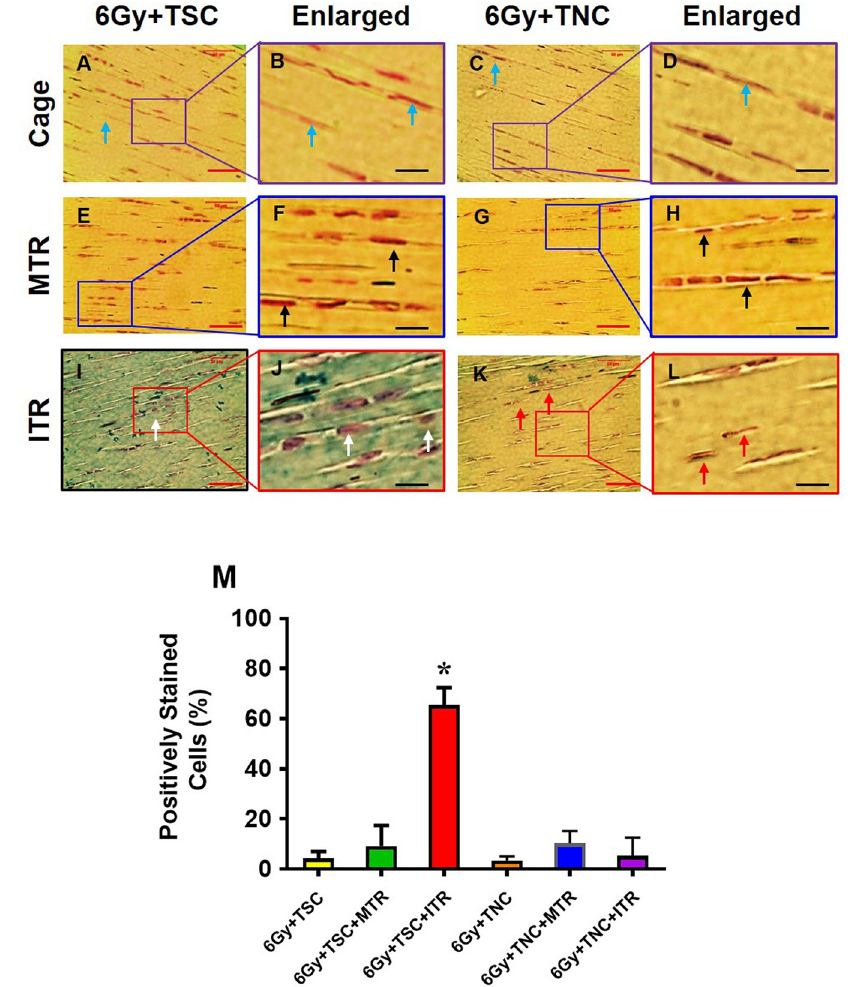
Fig 5. ITR induces chondrogenic differentiation of TSCs in irradiated tendons. Histochemical staining by Alcian blue and nuclear fast red shows that the cells in cage control tendons injected either with TSCs ( A, B ) or with TNCs ( C, D ) are still in elongated shape (blue arrows in A, C ), and very few cells in cage control groups are positive for Alcian blue staining ( A-D ). Furthermore, both TSCs and TNCs in MTR tendons are still elongated shape (black arrows in F, H ) and a few TSCs are positively stained by Alcian blue after MTR ( E, F ). However, some cells in ITR tendons are round shaped (white arrows in I, J ), and many TSCs are positively stained by Alcian blue ( I, J ) after ITR. The TNCs are still in elongated shape (red arrows in K, L ) and very little positive staining by Alcian blue ( K, L ). Semi- quantification of the chondrocyte staining shows that 66% of TSCs are positively stained with Alcian blue, and only 5% TNCs after ITR, and very few cells in cage control tendons and TSCs in MTR tendons are positively stained by Alcian blue ( M ). Graph bars represent the mean ± SD. � p < 0.05 compared to normal tendon. For each irradiated cage, MTR, and ITR group, n = 6 mice as described in Fig 5. Red bars: 50 μ m; black bars: 12.5 μ